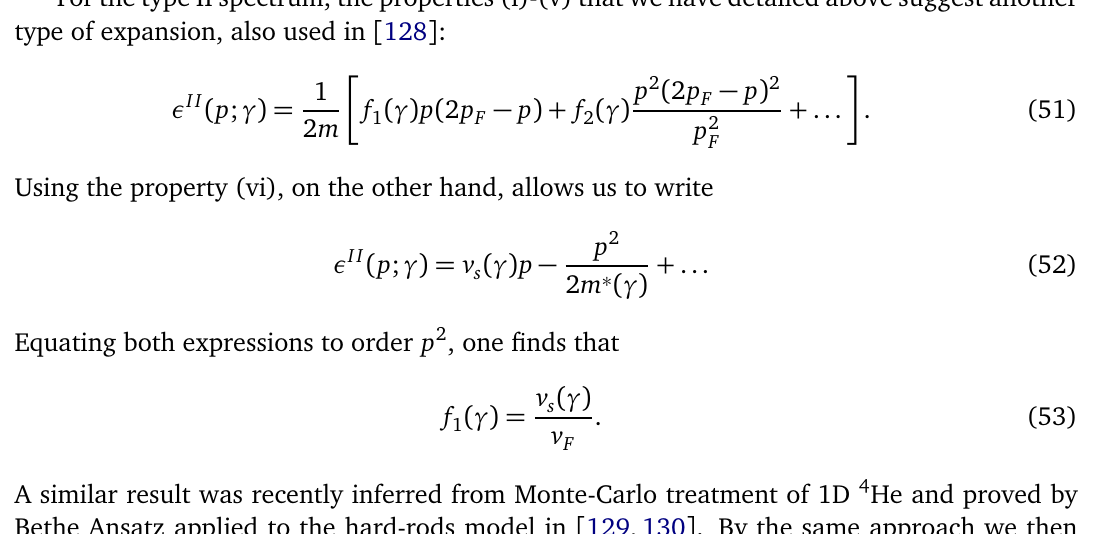
, ε = 0 of the Luttinger F (cid:39) 0.330581 and F